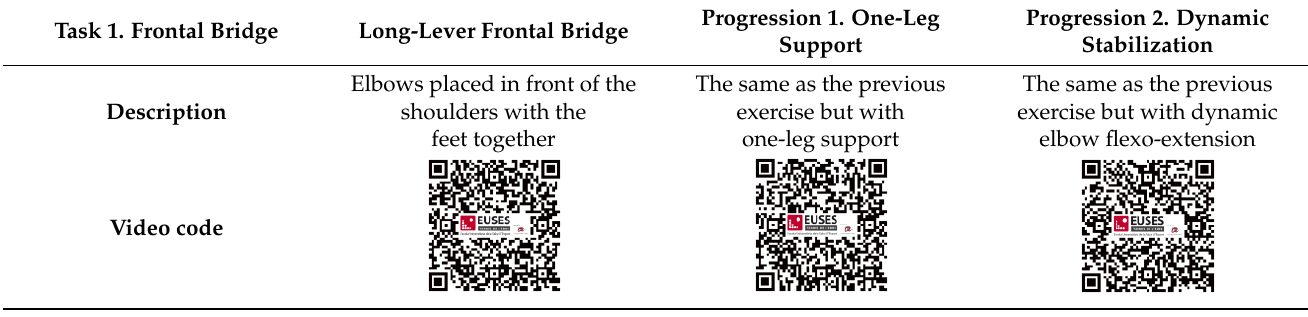
Table 6. Description and methodologic criteria of GCS group’s task 1 and its progressions. Task 1. Frontal Bridge